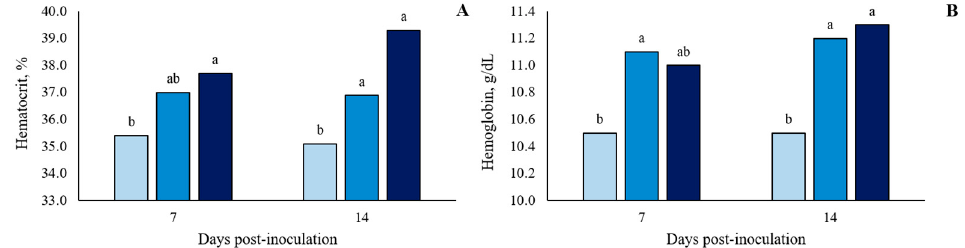
Figure 5. Hematocrit concentration ( A ) and hemoglobin content ( B ) of growing pigs orally challenged or not with Salmonella Typhimurium. ( (cid:4) ) Pigs without Salmonella Typhimurium challenge (Basal); ( (cid:4) ) Pigs orally challenged with 1 × 10 8 CFU of Salmonella Typhimurium; ( (cid:4) ) Pigs orally challenged with 1.5 × 10 8 CFU of Salmonella Typhimurium. Means followed by the different letters on the same day differ by Tukey’s test ( p < 0.05).